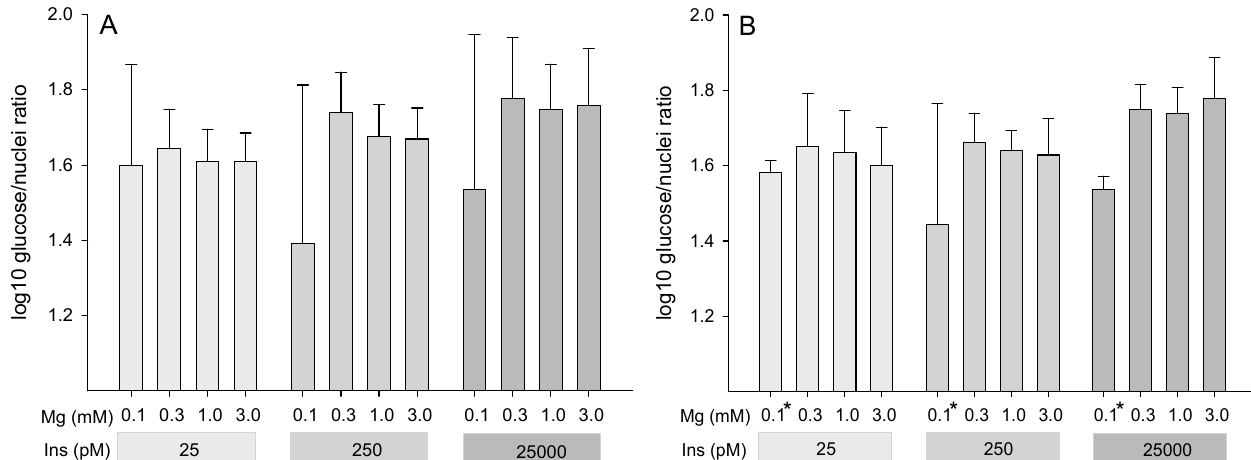
Figure 3. Assessment of the capacity for glucose uptake using the fluorescent glucose analog 6-NBDG (ex. 485 nm/em. 530 nm) after 14 days ( A ) and after 21 days ( B ) in various differentiation media containing different concentrations of magnesium (Mg) or insulin (Ins). DAPI fluorescence (ex. 358 nm/em. 461 nm) was used for normalization and results are expressed as log-transformed glucose/nuclei ratio. Results are means ± SD of six animals with two replicates per animal. * Asterisks indicate smaller LSM at 0.1 mM Mg compared to all other Mg concentrations ( P ≤ 0.05). After 21 days of cultivation, the trend for effect of insulin concentration persisted ( P = 0.10); however, log-transformed glucose/nuclei ratio was now significantly affected by the factor Mg ( P = 0.007) with no Mg × insulin interaction ( P = 0.25). The lowest tested